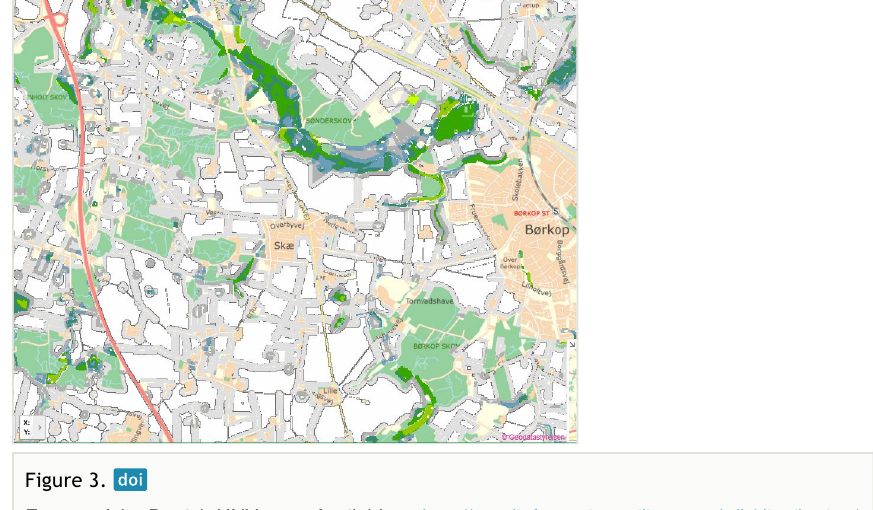
Extract of the Danish HNV map. Available at